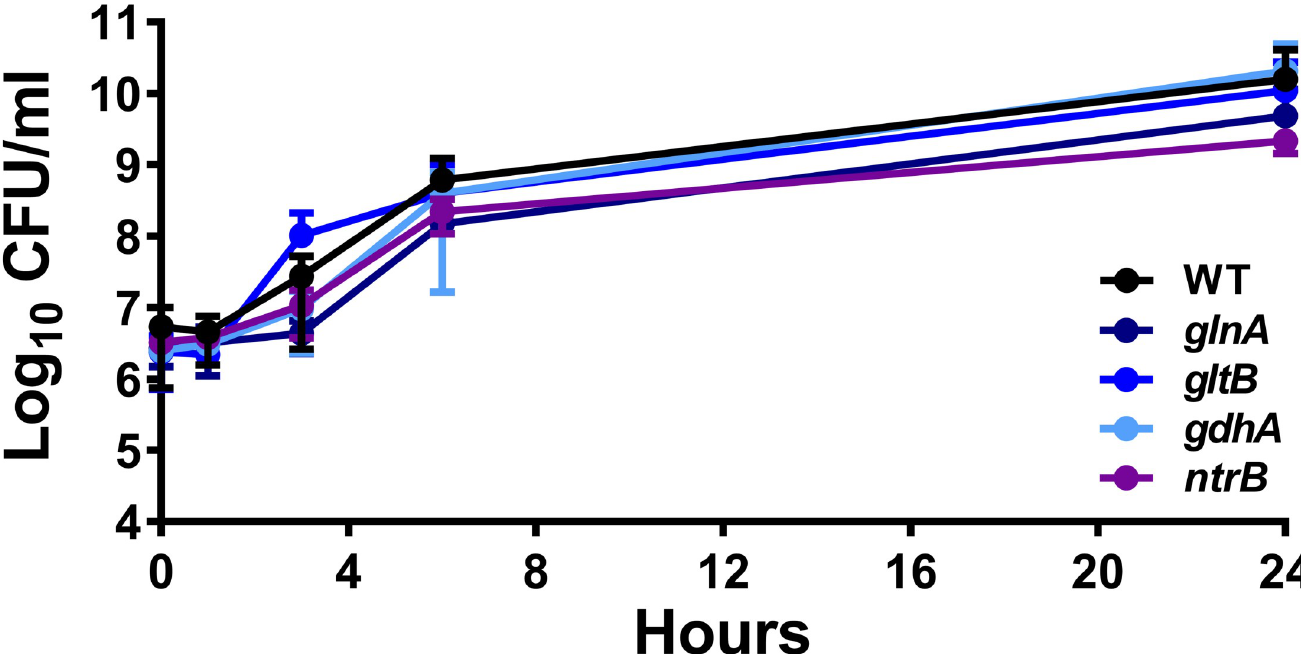
Fig 8. Nitrogen assimilation does not contribute to growth in serum ex vivo . 50% naive mouse serum was inoculated with 1x10 6 CFU wild-type P. mirabilis or an isogenic mutant glnA, gltB, gdhA , or ntrB . Cultures were incubated statically at 37˚C with 5% CO2 and sampled at 0, 1, 3, 6, and 24 hours for enumeration of CFUs on LB agar. Data for the gltB mutant are provided from Fig 4 for comparison. Error bars represent the mean ± standard deviation from three biological replicates.